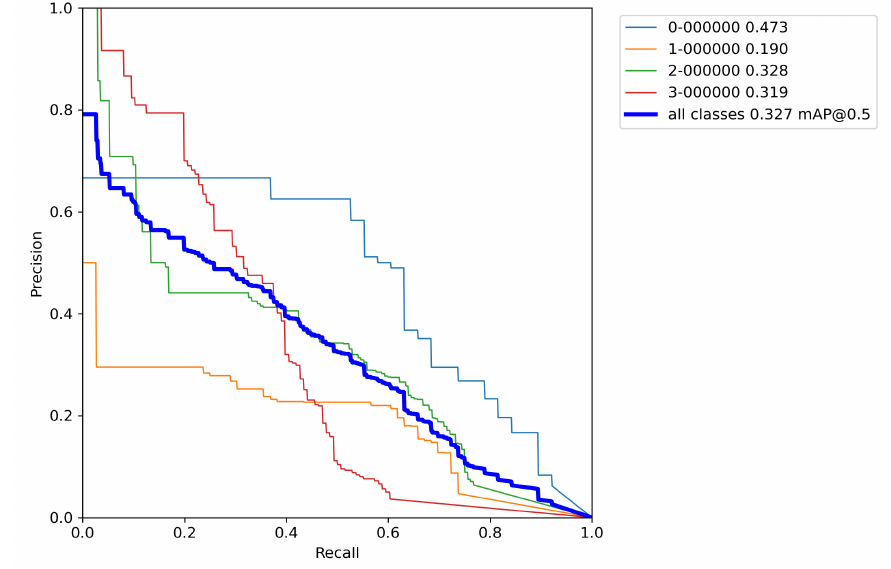
Figure A7. Model trained with classic augmentation techniques P–R curve—Experiment